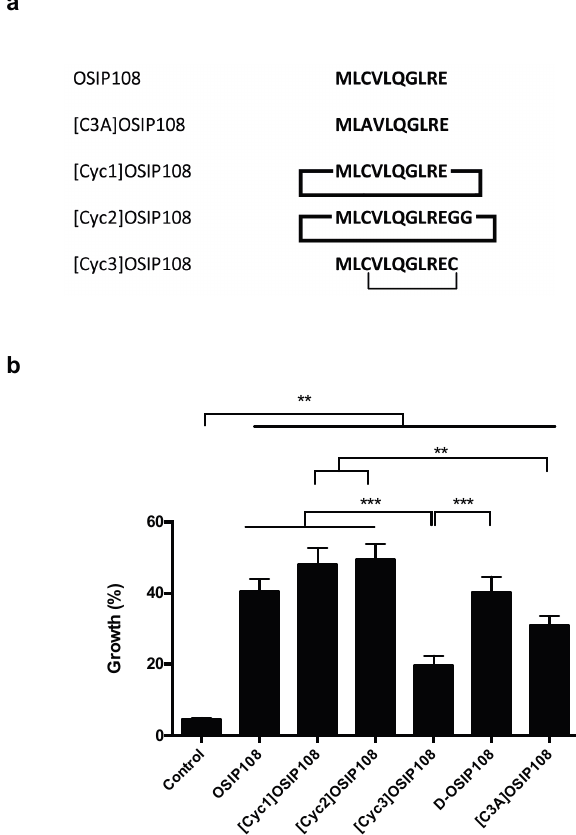
structure of OSIP108, [C3A]OSIP108 and cyclic derivatives tested in this study. Thick black lines represent head-to-tail cyclization; thin black line indicates disulfide bridge; ( b ) WT yeast cells were incubated with 250 µM Cp for 16 h in presence of control (2.5% DMSO) or 100 µM OSIP108, [Cyc1]OSIP108, [Cyc2]OSIP108, [Cyc3]OSIP108, D -OSIP108 or [C3A]OSIP108. Following incubation, cells were plated onto YPD agar plates and growth was calculated by determining CFU/mL as compared to cells receiving no Cp. Experiment performed in quadruplicate, biological repeats is three. ( ** p < 0.01; *** p < 0.001; ANOVA test using Tukey